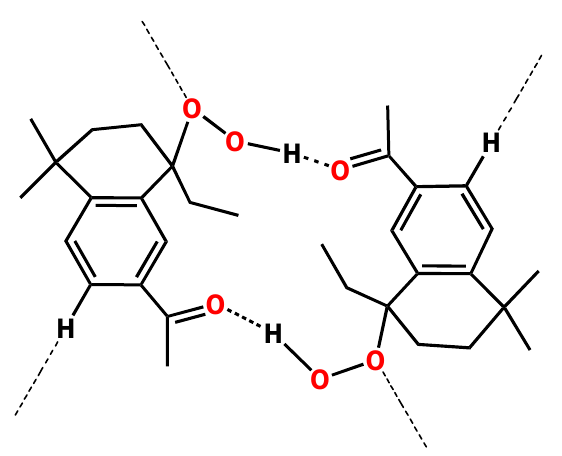
Figure 4. Hydrogen-bond